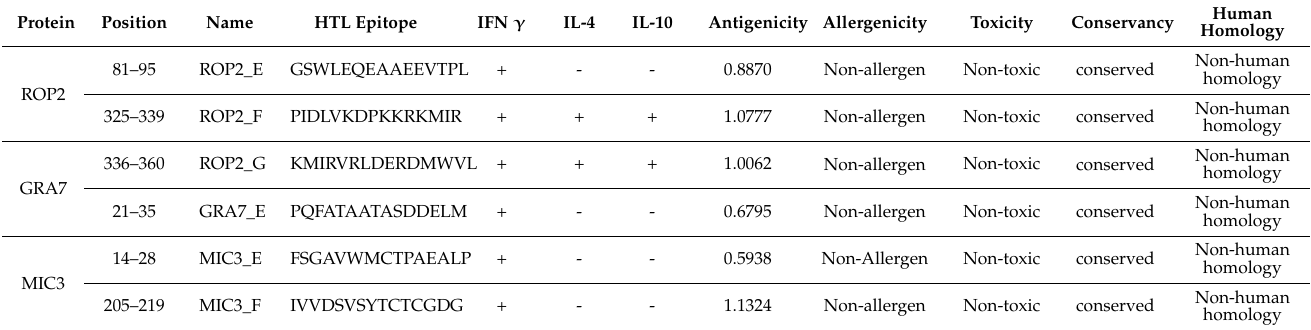
Table 3. HLT epitopes selected for vaccine